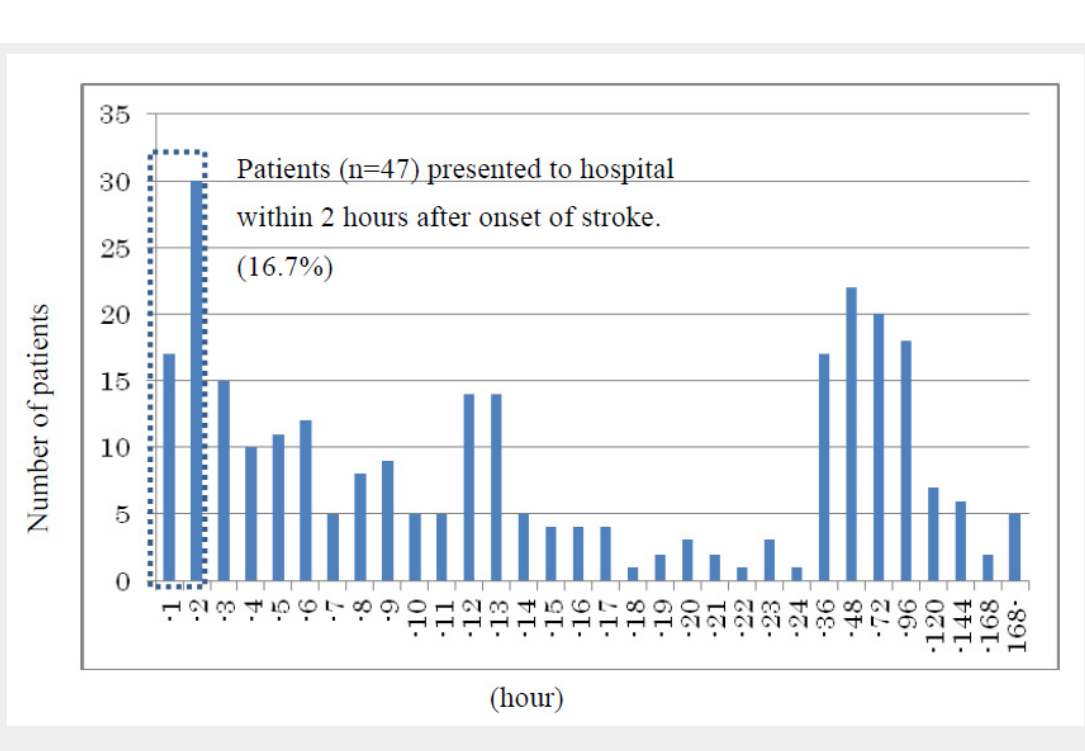
Figure 1 Distribution of time to presenting to hospital from onset of stroke